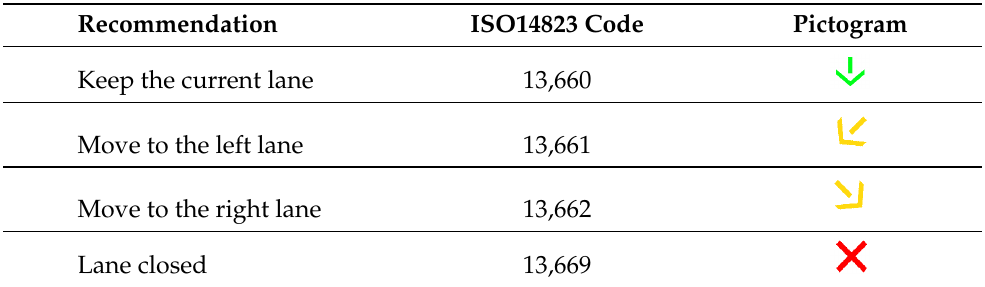
Table 1. IVIM lane choice recommendation according to the ISO 14823:2017